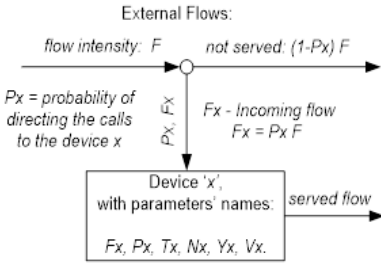
Figure 2. Virtual device parameters.